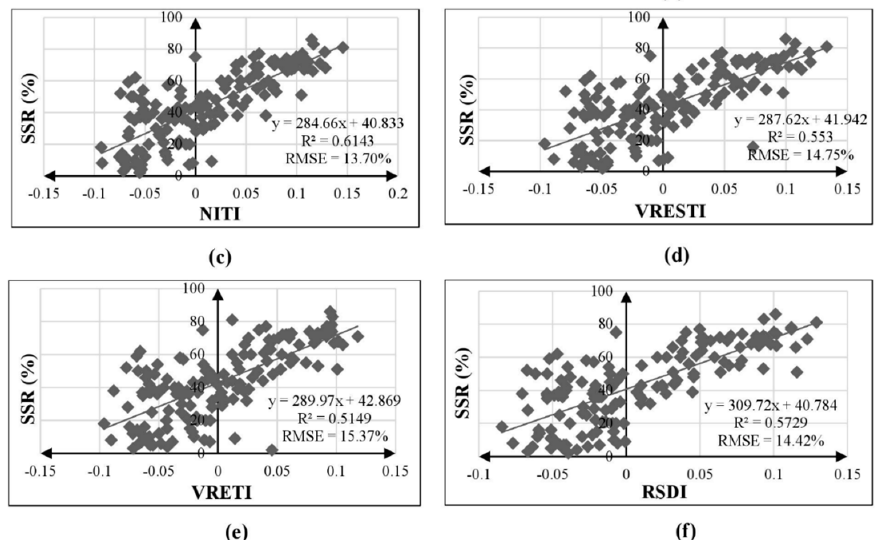
Figure 6. Linear regression between Sentinel-2A-based tillage indices and SSR: ( a ) Sentinel normalized difference tillage index (SNDTI), ( b ) Sentinel simple tillage index (SSTI), ( c ) Narrow near infrared tillage index (NITI), ( d ) Vegetation red edge shortwave tillage index (VRESTI), ( e ) Vegetation red edge tillage index (VRETI), and ( f ) Red shortwave difference index (RSDI).